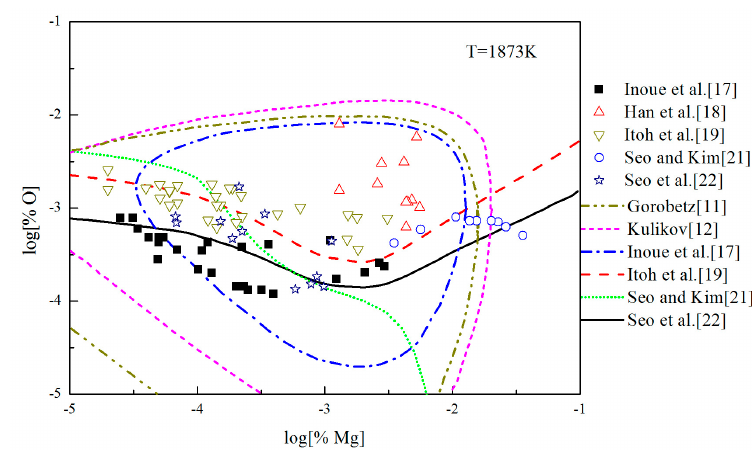
Figure 8. Equilibrium experiments of Mg-deoxidation in liquid iron at 1873 K.